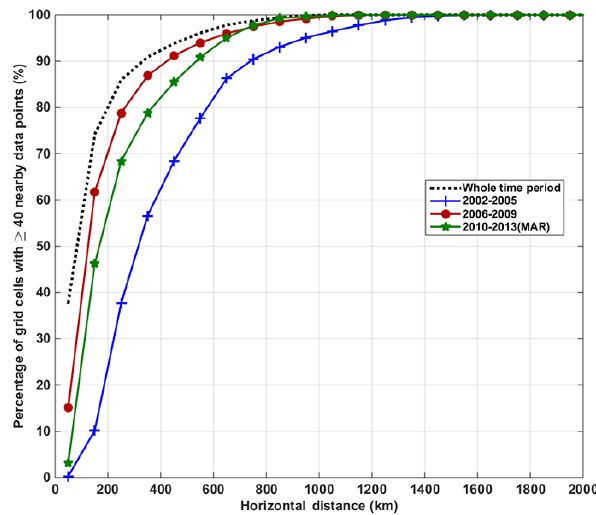
Figure 8. The percentage of grid cells with at least 40 profiles within areas of different radii, for different horizontal distances (km).